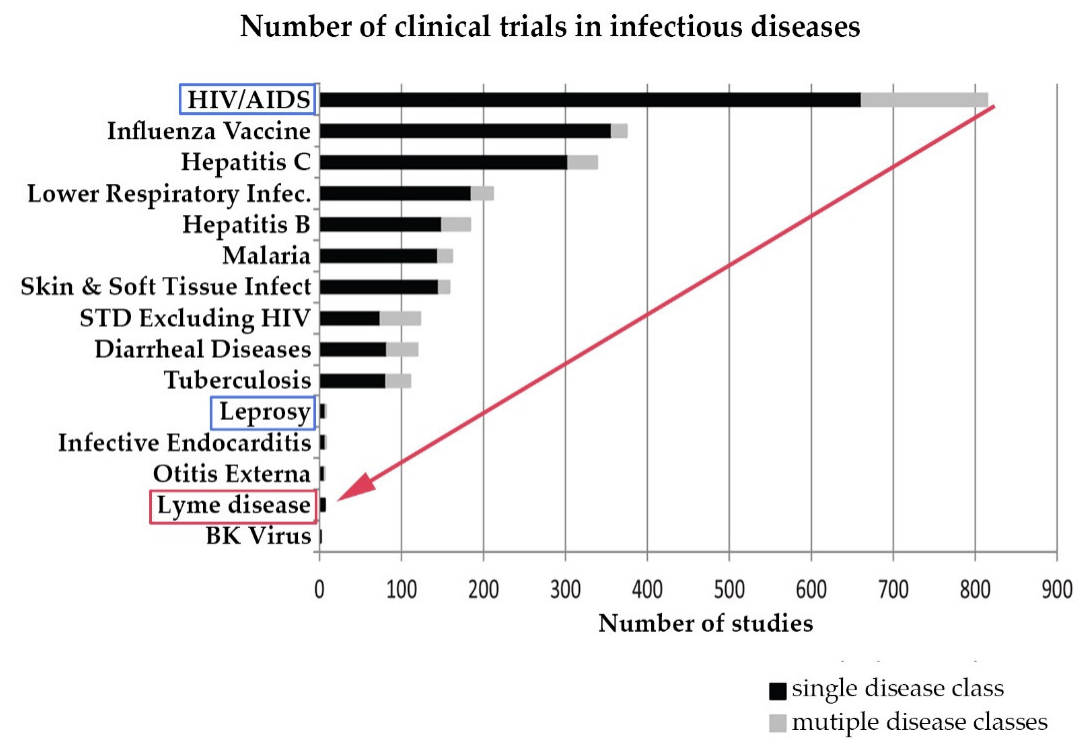
Figure 4. Research in Lyme disease is sparse compared to other infectious diseases. (Derived from Goswami 2013 [10]).